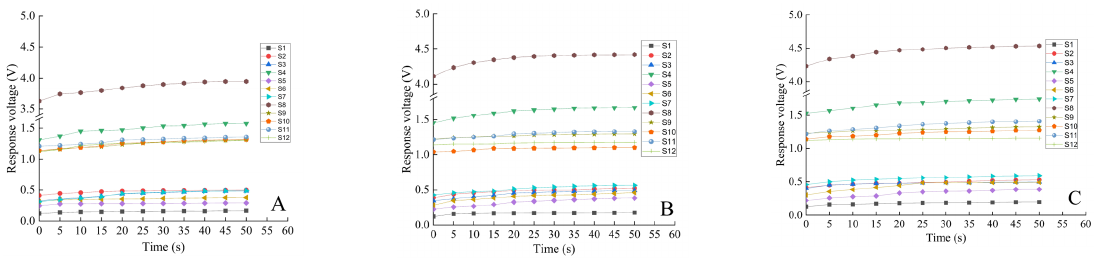
Figure 3. Electronic-nose device schematic diagram.